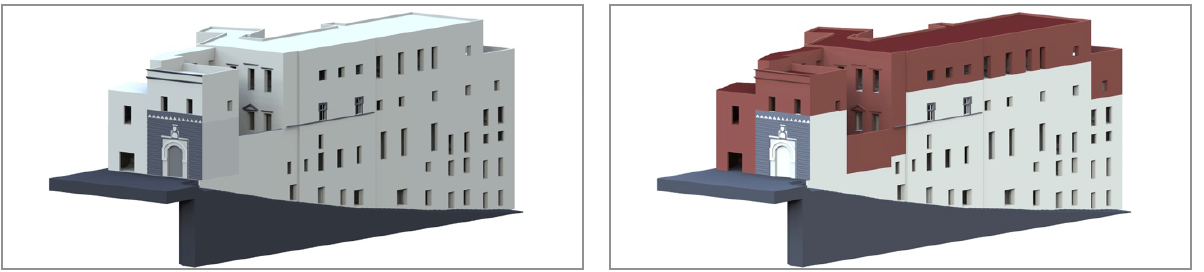
Figure 6. Palazzo Penne, view on Pendino S. Barbara alley, eighteenth-century additions. 3D Modeling by S. Scandurra